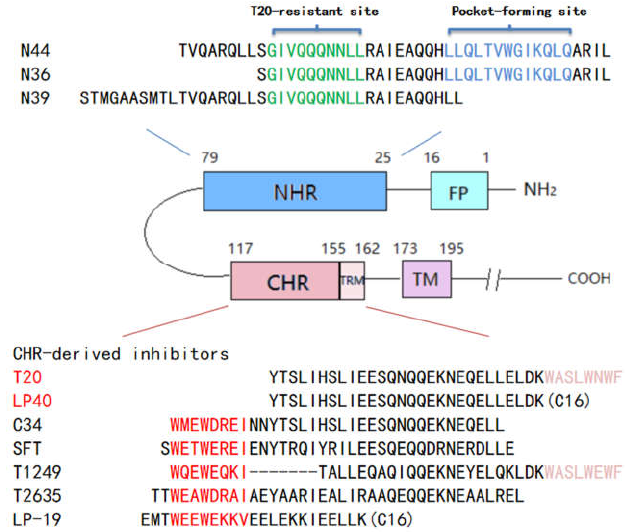
Figure 1. Schematic illustration of HIV gp41 and peptide fusion inhibitor. FP, fusion peptide; NHR, N-terminal heptad repeat; CHR, C-terminal heptad repeat; TRM, tryptophan-rich motif in the CHR; TM, transmembrane domain; CT, cytoplasmic tail. The sequences corresponding to the T20-resistant site and the pocket-forming site are marked in green and blue, respectively, on the NHR-derived peptide N36. The sequences corresponding to the pocket-binding site and TRM are marked in red and purple, respectively, on the CHR-derived peptide C34.